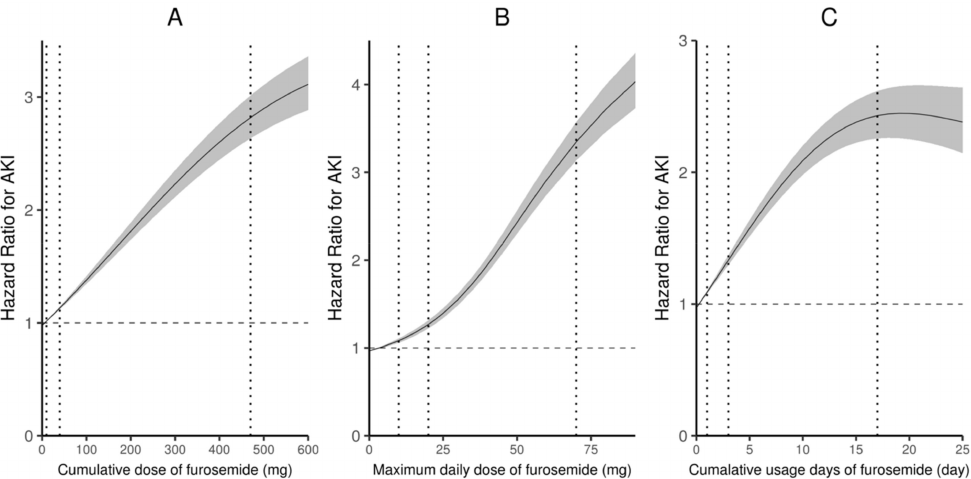
Figure 2. Response curves of furosemide with the risk of HA-AKI based on a penalized smoothing spline. There was a linear, positive association between cumulative dose ( A ), maximum daily dose ( B ), cumulative usage days ( C ), and HA-AKI. Adjusted for age, gender, estimated glomerular filtration rate, number of serum creatinine tests, Charlson Comorbidity Index score, need for admission to the intensive care unit, mechanical ventilation, comorbidities, surgical procedures, and use of other nephrotoxic drugs, and stratified by hospitals and divisions. The leftmost, middle, and rightmost vertical lines indicate 25%, 50%, and 75% of the x -axis, respectively. HA-AKI, hospital-acquired acute kidney injury; mg,